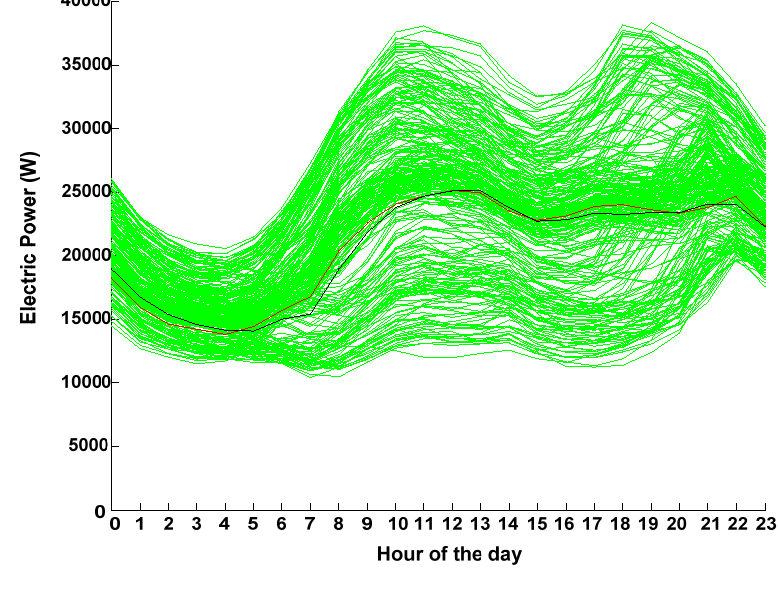
Figure 4. Load curves for non-holiday Wednesday are represented in green. Load curve for 30/06/2010 is represented in red, and the forecasting for that day is shown in